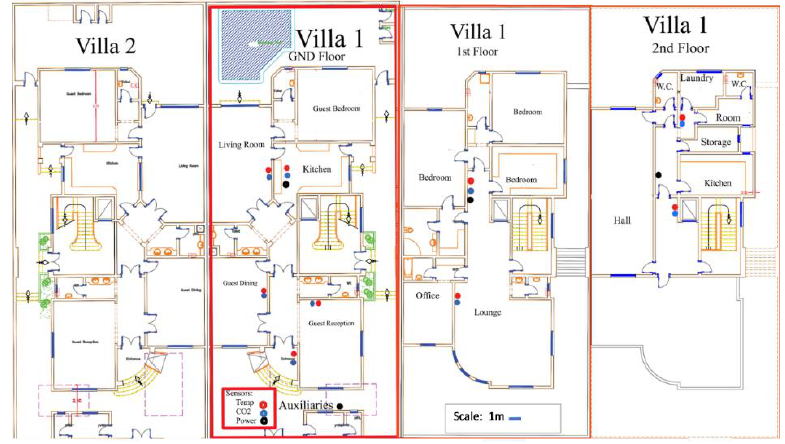
Figure 5. Layout showing sensor location for the ground floor, 1st floor, and 2nd floor for Villa 1.